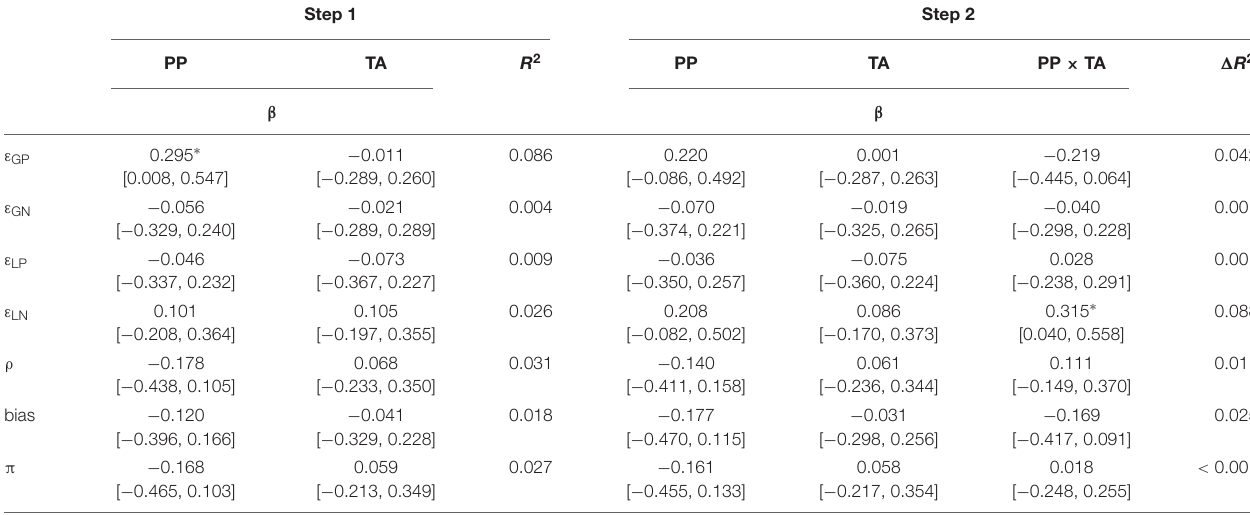
TABLE 4 | Results of hierarchical regression analyses for each learning parameter predicted by primary psychopathy and trait anxiety scores. Step 1 Step